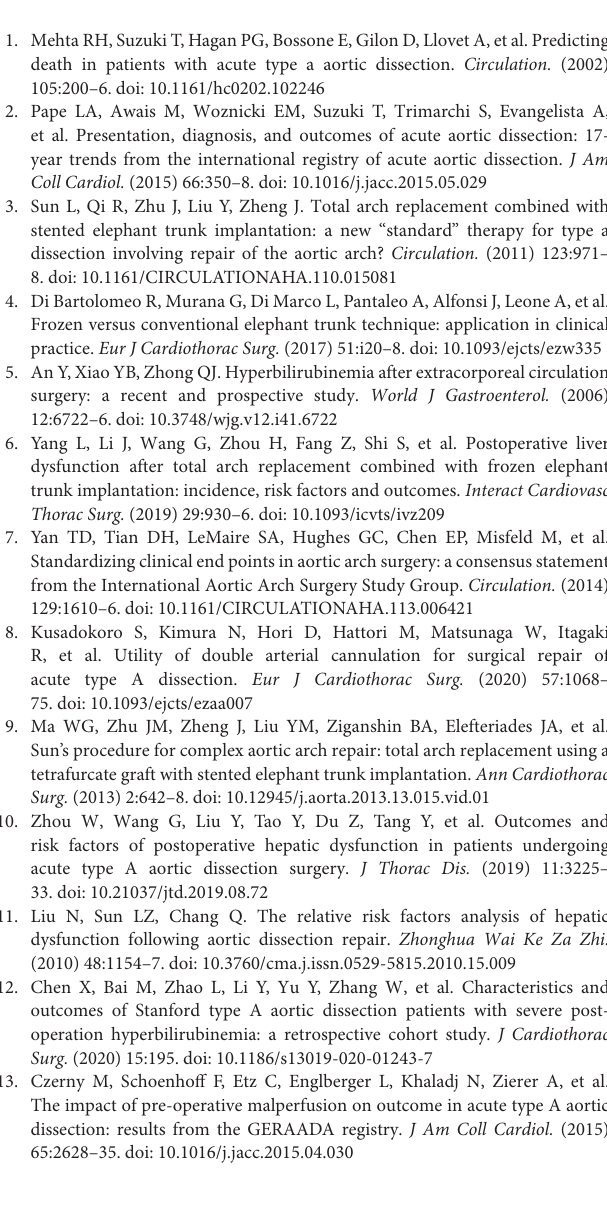
Supplementary Table 1 | Variables considered in multivariable analyses. Supplementary Table 2 | Details of the multivariable mixed effect logistic